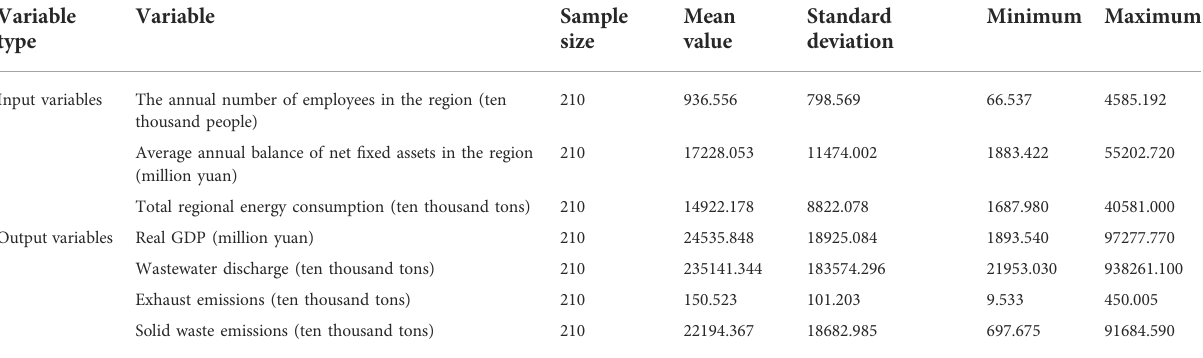
TABLE 4 Input and output variables of green total factor